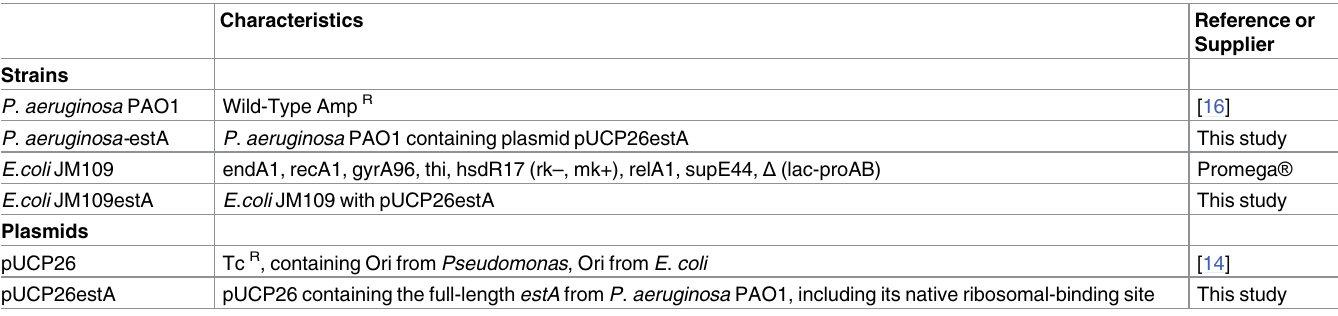
Table 1. Strains and plasmids used at this